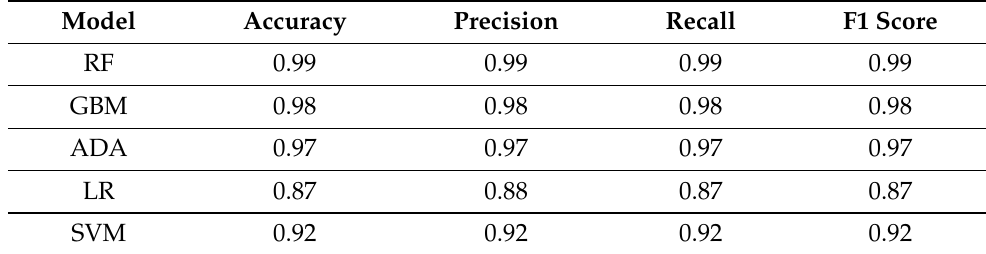
Table 13. Performance of models using MLFS feature